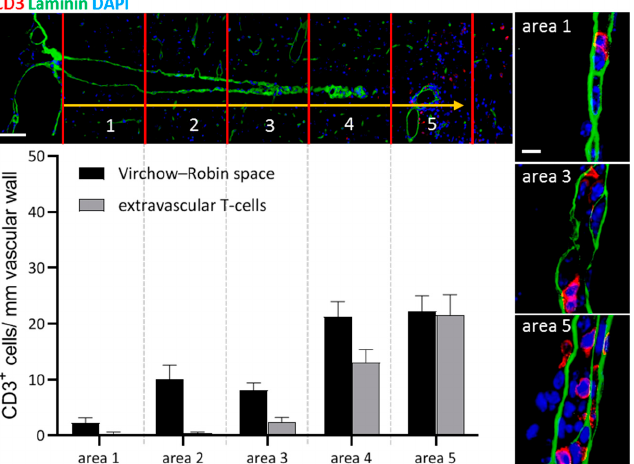
Figure 2. CD3 + lymphocytes (red) along a penetrating blood vessel in Cup/EAE mice. The brain surface is shown on the left. Area 1 represents the most superficial part of the neocortex whereas Area 5 is adjacent to the white matter tract corpus callosum. The perivascular Virchow–Robin space is demarcated by the two basal laminae (laminin + ; green). Note the increasing cell densities towards the depth of the brain. Scale bars: upper left: 100 µm, right: 10 µm.